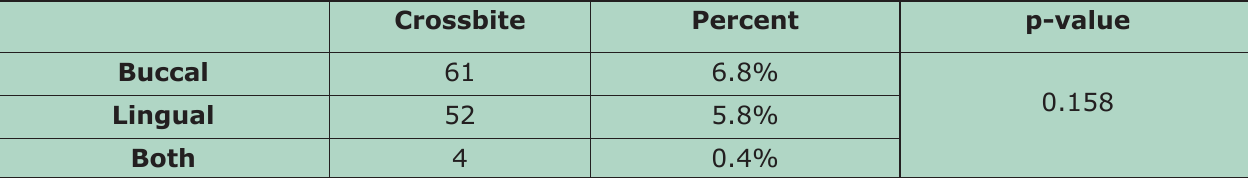
Table V: Prevalence of buccal and